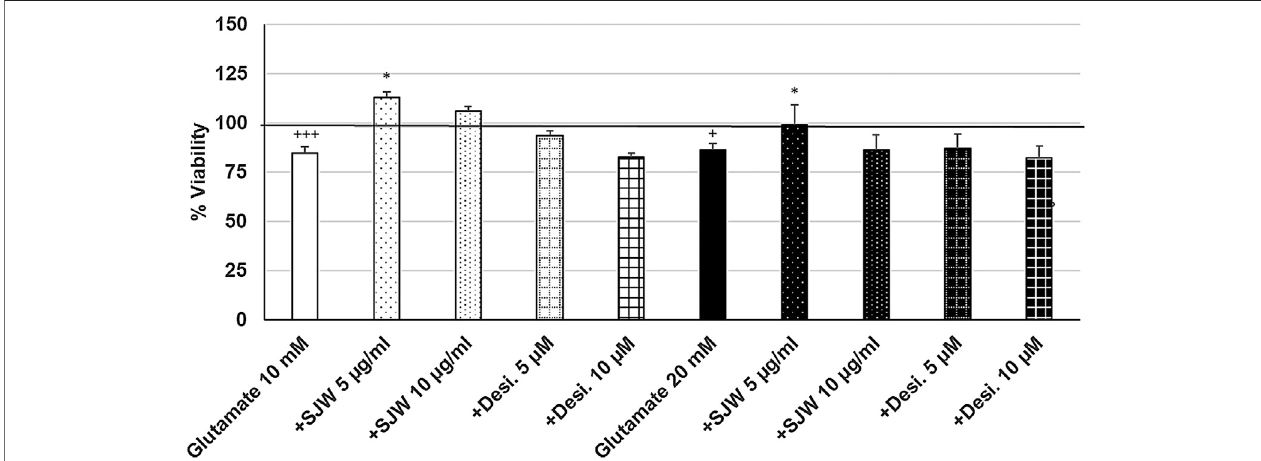
FIGURE 5 | Effects of 48 pre-treatment with STW3-VI [St. John ’ s wort (SJW)] or desipramine and afterwards 24 h co-incubation with glutamate (10 or 20 mM) on viabilityofmouseSIM-A9microglia.ViabilitywasmeasuredbyPrestoBlue ® assay.Values[in%viabilityofuntreatedcontrol(control (cid:2) 100%viability)]aregivenasmean+ SEM; signi fi cance (by T-TEST): * p < 0.05, vs. glutamate; + p < 0.05, +++ p < 0.001 vs. untreated control (100%); n (cid:2) 4 ‒ 12.